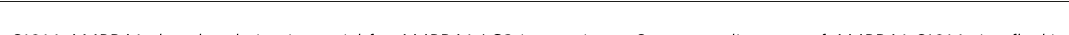
Fig. 3 S1014-AMBRA1 phosphorylation is crucial for AMBRA1 – LC3 interaction. a Sequence alignment of AMBRA1 – S1014 site, fl anking its LIR motif, in comparison with the S1014A (phospho-dead) and S1014D (phospho-mimetic) generated mutants. b HeLa transfected with Myc-AMBRA1 WT , Myc- AMBRA1 S1014A or Myc-AMBRA1 S1014D were treated or not with O/A (2.5 μ M, 0.8 μ M, 1 h) and subjected to co-immunoprecipitation (Co-IP). The graph shows the ratio between Co-IP LC3II/IP-AMBRA1 upon mitophagy induction; n = 3. Statistical analysis was performed using Student ’ s t -test versus the wild-type form of AMBRA1. c PcDNA3, Myc-AMBRA1 WT , Myc-AMBRA1 S1014A or Myc-AMBRA1 S1014D transfected HeLa cells were treated with O/A (2.5 μ M, 0.8 μ M, 4 h) and blotted for COXII, COXIV, Myc and ACTIN; n = 3. d Cells transfected with a vector encoding for GFP, Myc-AMBRA1 WT , or Myc- AMBRA1 S1014A or Myc-AMBRA1 S1014D were treated with O/A as indicated above and stained with anti-Myc and anti-TOM20 (red staining) antibodies. Scale bar, 10 μ m; n = 3. Myc-AMBRA1 WT = 9 individual fi elds; Myc-AMBRA1 S1014A = 9 individual fi elds; Myc-AMBRA1 S1014D = 9 individual fi elds. e Untransfected HeLa cells were treated with mitophagy inducers, such as FCCP (10 μ M) and O/A (2.5 μ M and 0.8 μ M) or with the starvation medium EBSS in order to induce autophagy for 4 h; n = 3. Data represent the mean of three different samples (±S.D.) and are representative of